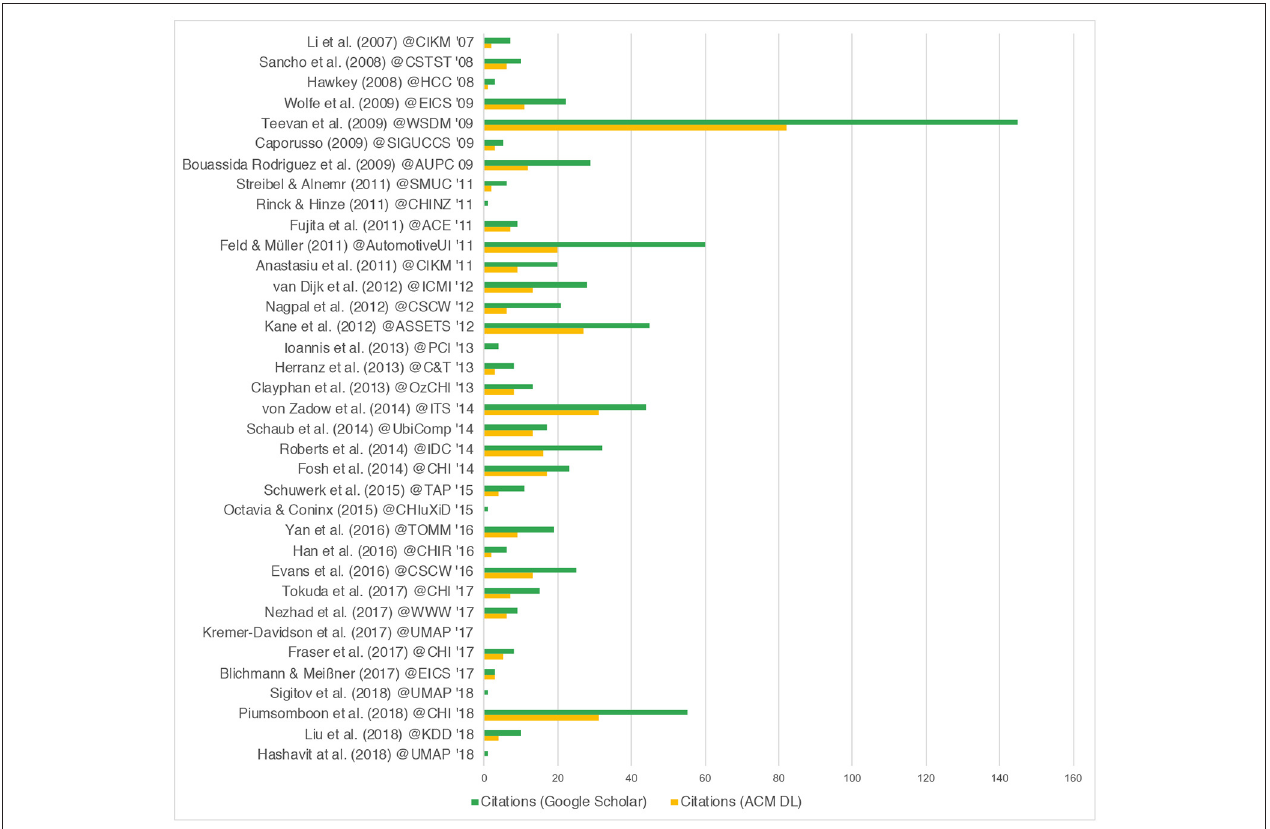
FIGURE 3 | Citations and conferences/journals (TAP and TOMM) for each paper. Citations were retrieved from ACM Digital Library (DL) and Google Scholar on May 7,